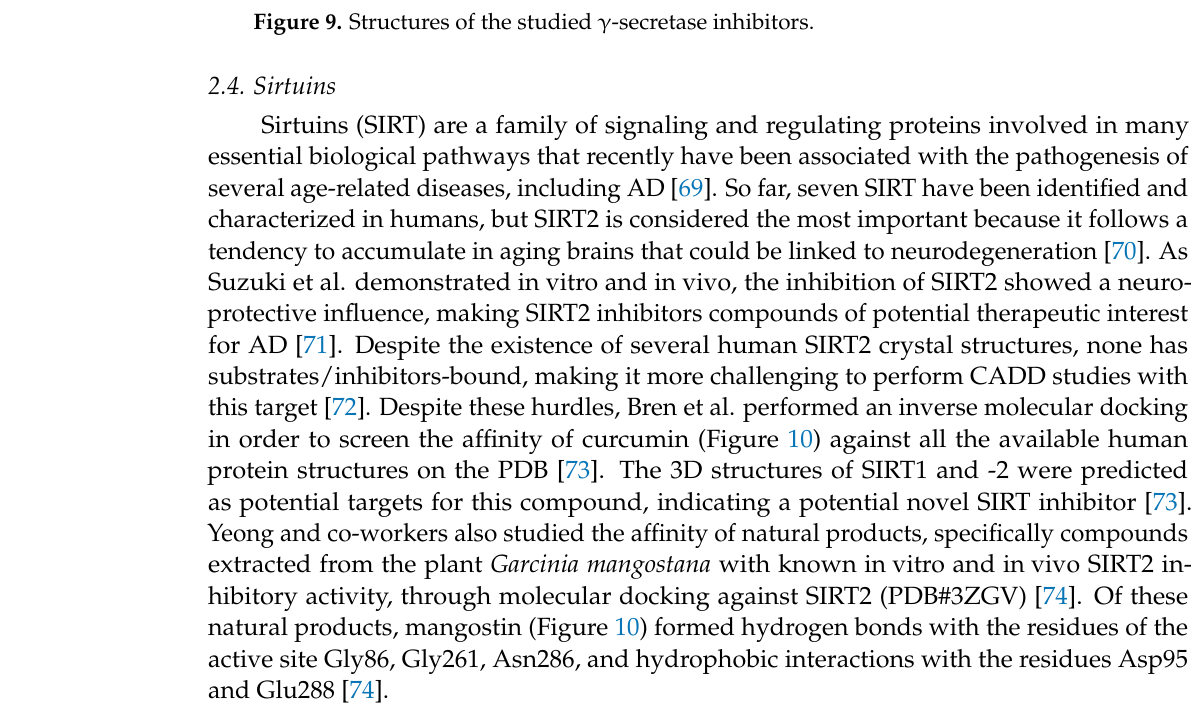
Figure 9. Structures of the studied γ -secretase inhibitors.